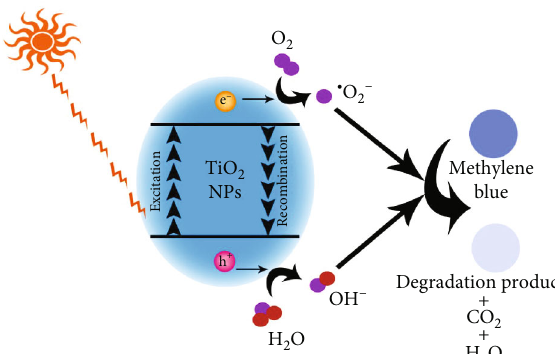
Figure 9: Photocatalysis mechanism for TiO UV light illumination to degrade MB dye